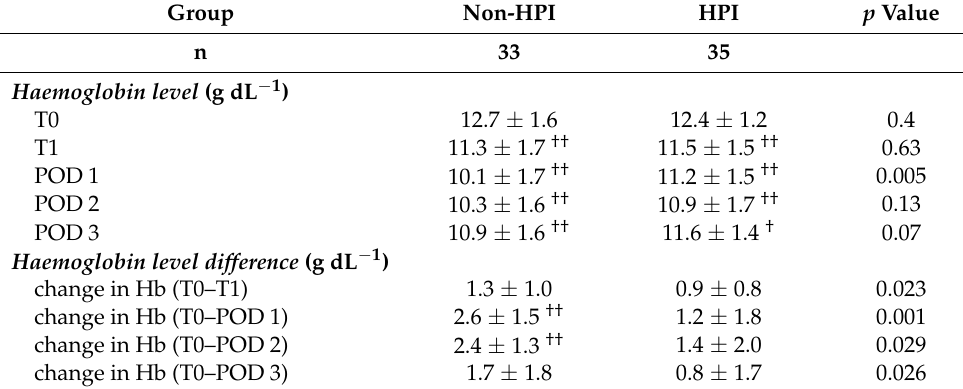
Table 4. Haemoglobin outcomes.